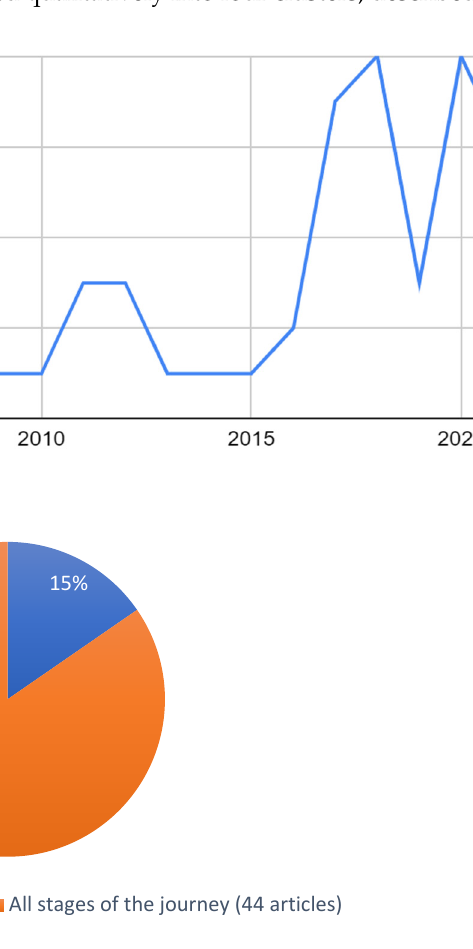
Figure 3. Scope of Figure 3. Scope of research.